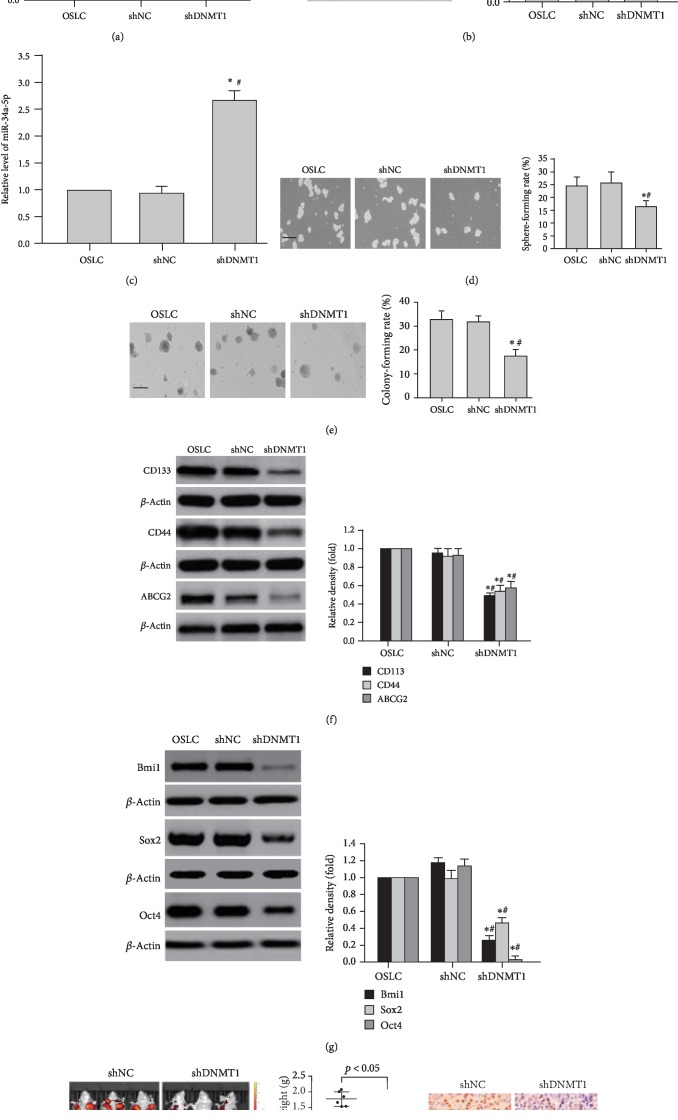
Effects of DNMT1 knockdown on the stemness feature in OSLCs. (a, b) qRT-PCR and immunoblot were performed to detect DNMT1 mRNA and protein in OSLCs transfected with shRNA DNMT1, respectively, with β-actin serving as a loading control. (c) qRT-PCR analyzed miR-34a-5p expression in OSLCs knocking down DNMT1. (d) Representative images of the spheres of OSLCs transfected with shNC or shDNMT1 (left) (scale bar, 200 μm) and sphere-forming rate (right). (e) Representative images of the colonies of OSLCs transfected with NC or DNMT1 shRNA (left) (scale bar, 200 μm) and colony-forming rate (right). (f) CD133, CD44, and ABCG2 proteins in OSLCs transfected with shNC or shDNMT1 (left) and their densitometric analysis (right). (g) Bmi1, Sox2, and Oct4 in OSLCs transfected with shNC or shDNMT1. ∗p < 0.05 (n = 3) vs. U2OS cell; #p < 0.05 (n = 3) vs. shNC. (h) The images of subcutaneous xenografts of OSLC (2 × 105) expressing red fluorescent protein (RFP) and shNC (left) and comparison of tumor weight of OSLCs expressing RFP and DNMT1 shRNA (right). The data were obtained from xenograft weighing results from 6 inoculation sites (n = 6). ∗p < 0.05 vs. OSLCs expressing RFP. The images of immunohistochemistry of DNMT1 protein expression under an optical microscope (right) (scale bar, 50 μm).